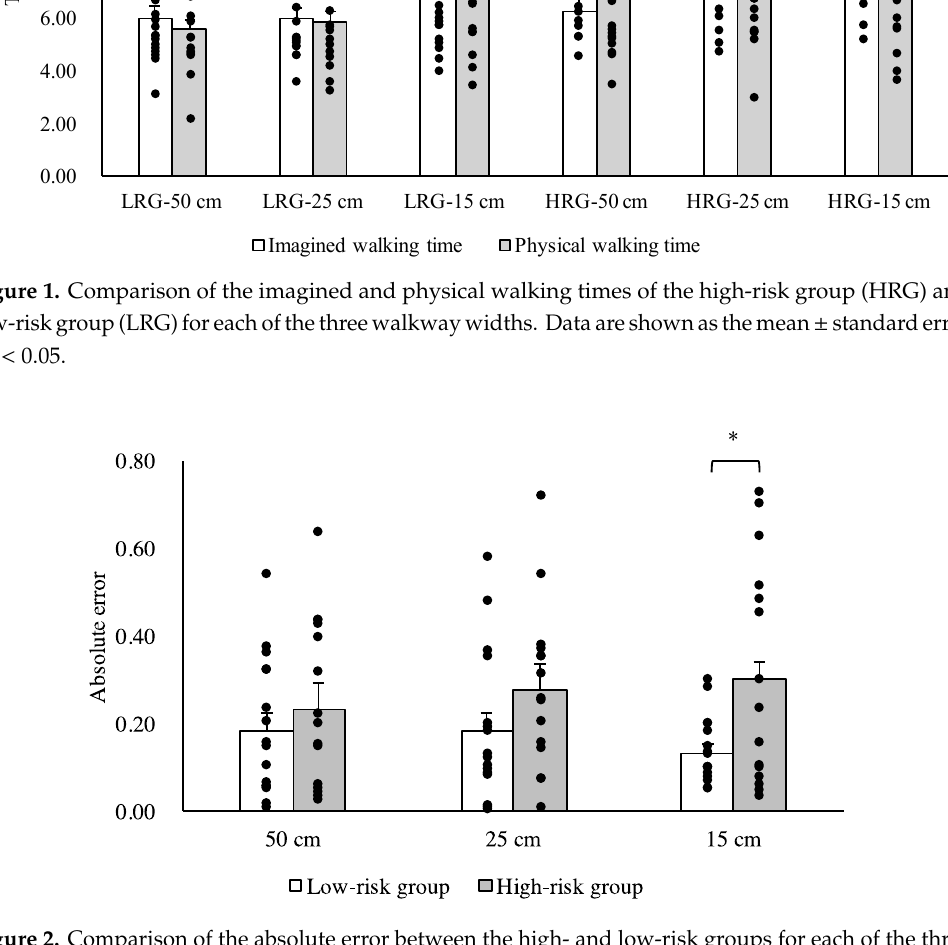
Figure 3. Comparison of constant error between the high- and low-risk fall groups for each of the three walkway widths. Data are presented as the mean ± standard error. * p < 0.05.